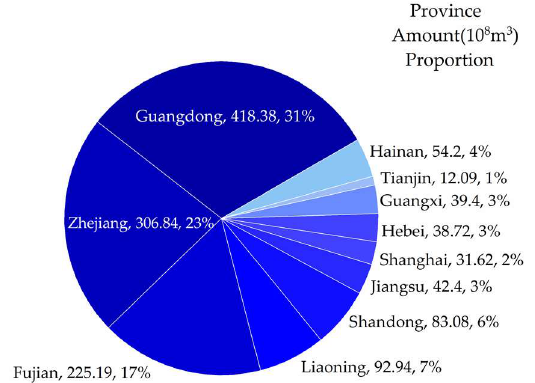
Figure 8. The amount and proportion of seawater used directly in cooling projects in the 11 coastal regions of China in 2017. Data Source: State Oceanic Administration, People’s Republic of China “The National Seawater Utilization Report in 2017” [25].